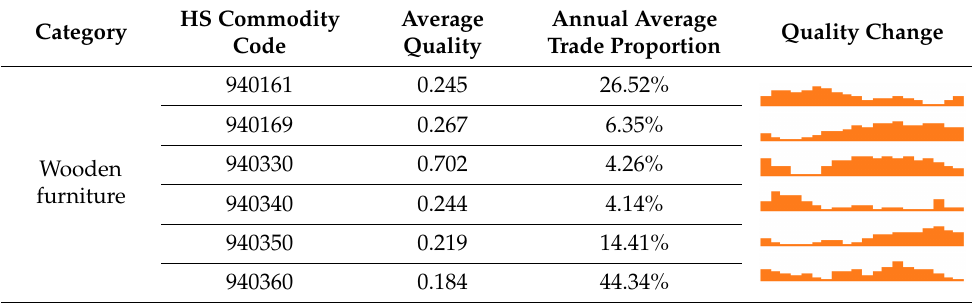
Table 5. Quality of wooden furniture by sub-category.